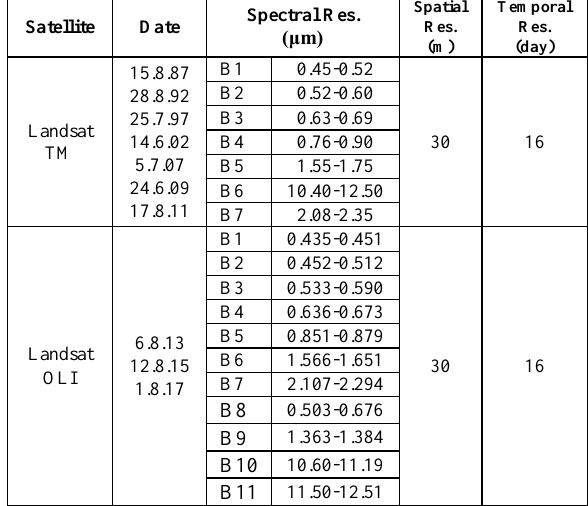
Table 1 Landsat satellite images used in Landtrendr